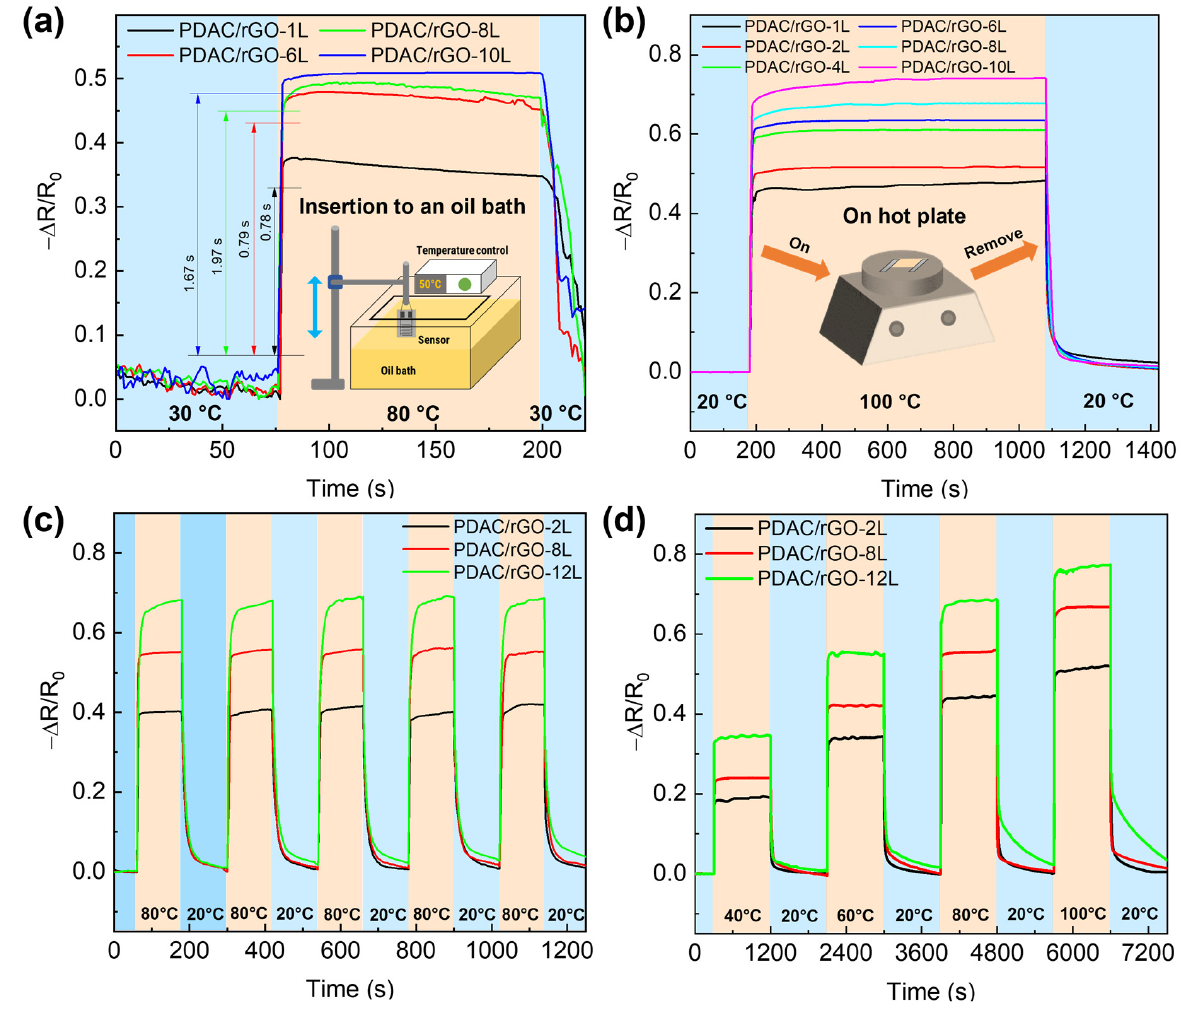
Figure 3. Dynamic thermal properties of PDAC/rGO sensors: ( a ) Response curves of PDAC/rGO sensors plunged abruptly in hot oil bath, and ( b ) recovery curves of PDAC/rGO sensors for different numbers of layers removed suddenly from hot plate; ( c ) repeatability and ( d ) step curves of thermal properties of PDAC/rGO sensors upon exposure to different heating – cooling programs.